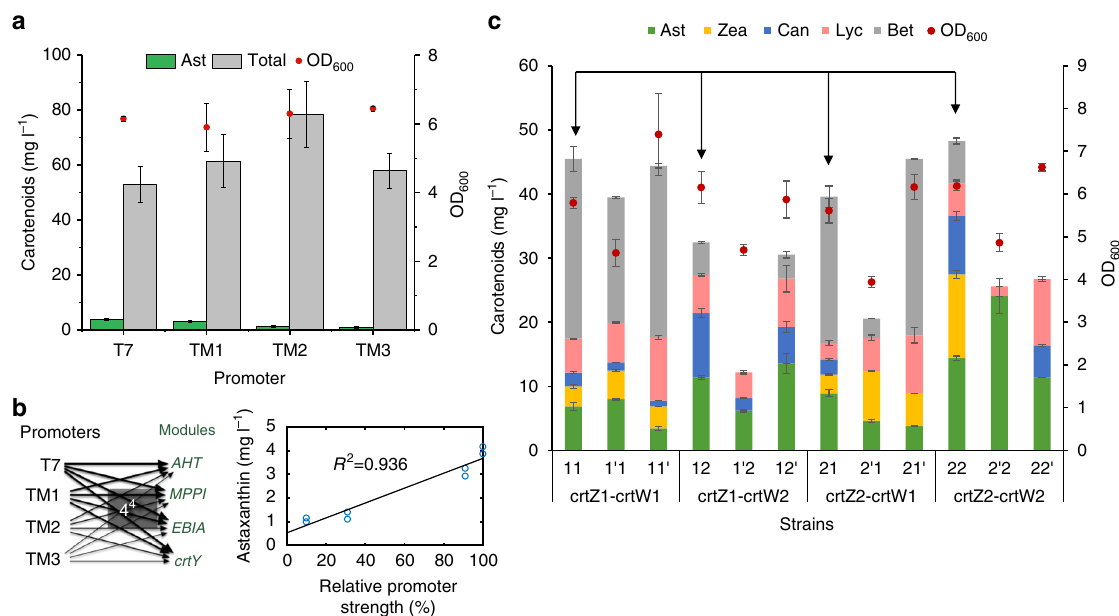
Fig. 3 Optimization of astaxanthin production. a Global optimization for astaxanthin production using promoters, which was performed based on the optimized lycopene and β -carotene strain (Figs. 2 and 3) by fi ne tuning the transcription of the YZW module. b Correlation between astaxanthin production and the promoter strength that controls the transcription of the three genes, crtY , crtZ and crtW in the YZW module. c The local optimization of astaxanthin by investigating different β -carotene hydroxylases ( crtZ ) and ketolases ( crtW ) and translational control of individual enzyme. Strains 11, 12, 21, and 22 stand for the combination of crtZ 1 and crtW 1, crtZ 1 and crtW 2, crtZ 2 and crtW 1 and crtZ 2 and crtW 2, respectively. The symbol ( ′ ) in the fi gure refers to a different RBS, for example, 1 ′ 1 refers to the crtZ 1 with a different RBS and 11 ′ refers to crtW 1 with a different RBS (Supplementary Table 1 and 2). Error bars, mean ± s. d., n = 2. Arrows refer to the comparison among the four different combinations of enzymes (no RBS effects), or strains 11, 12, 21, and 22. Ast